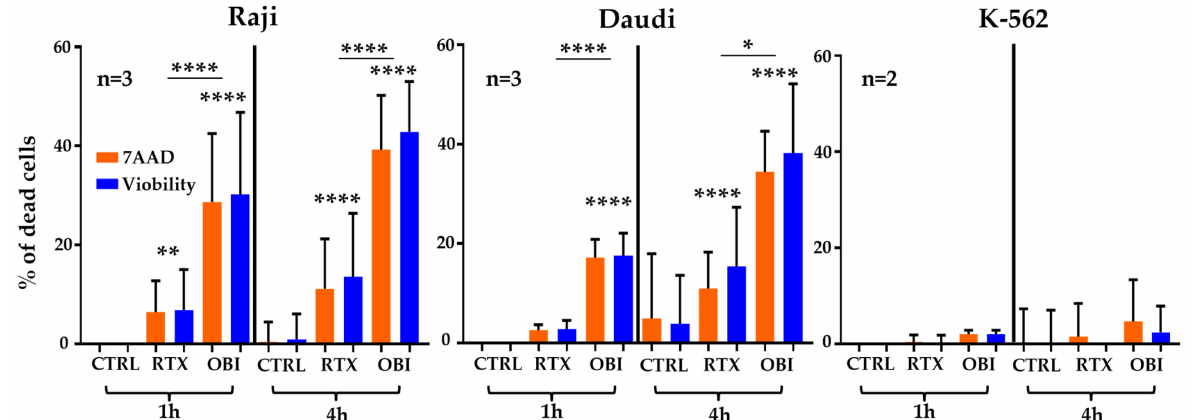
Figure 2. RTX and OBI induce quick direct cell death measured by 7AAD and Viobility TM and analyzed by FACs. The depicted cell lines (1 million/mL) were incubated with RTX or OBI (10 µ g/mL) for the indicated times. Then, cells were incubated with 7-AAD or Viobility TM 405/452, following the provider’s instructions. Cells were washed and cell viability analyzed by FACs, using a Beckman Coulter Gallios cytometer. The graphs display the percentage of dead cells after normalizing the death at time 0 to 0%. Graphs show mean +/ − SD of 3 (Raji and Daudi) or 2 (K-562) experiments performed in duplicate; * p < 0.05, ** p < 0.01, **** p < 0.0001; Tukey’s multiple comparisons test compared to control or as depicted in the graphics comparing groups to each other when using the same